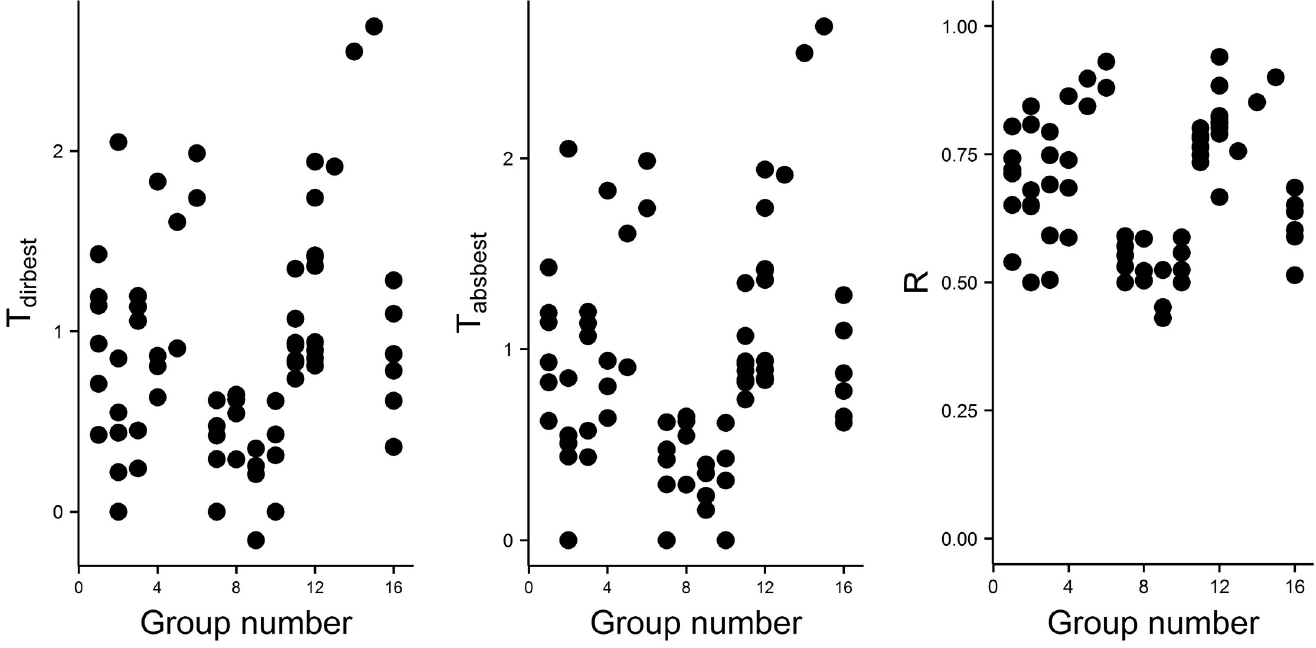
Fig 8. Plots of T pos , T neg , and R vs group number for all 68